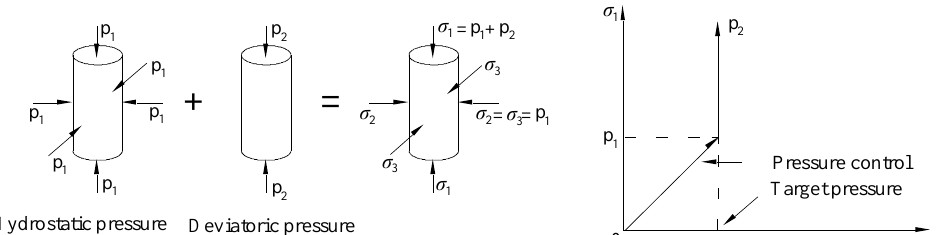
Figure 3. Loading device and specimen: ( a ) Loading device; ( b ) Specimen wrapped with thermoplastic pipe.